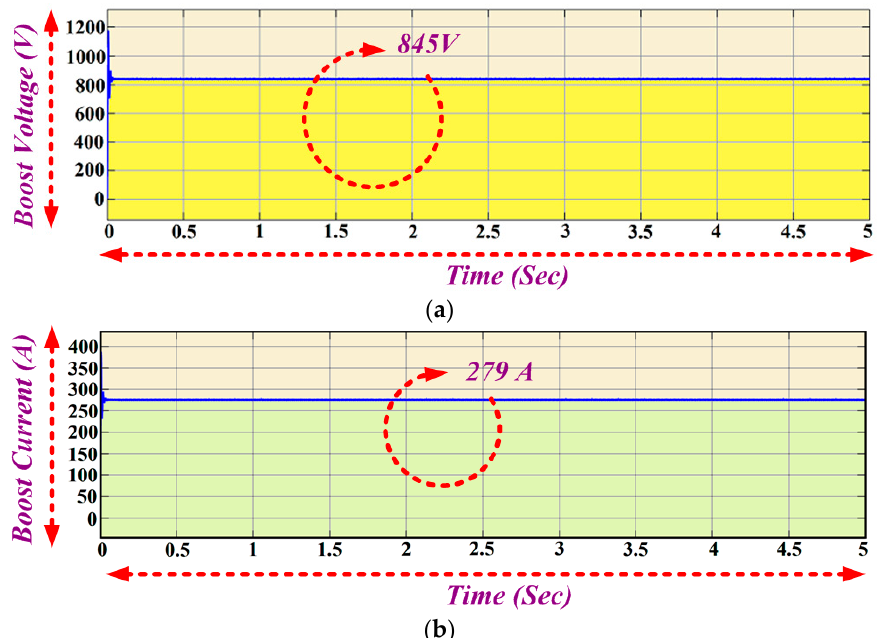
Figure 12. ( a ) Boost Voltage; ( b ) Boost Current.